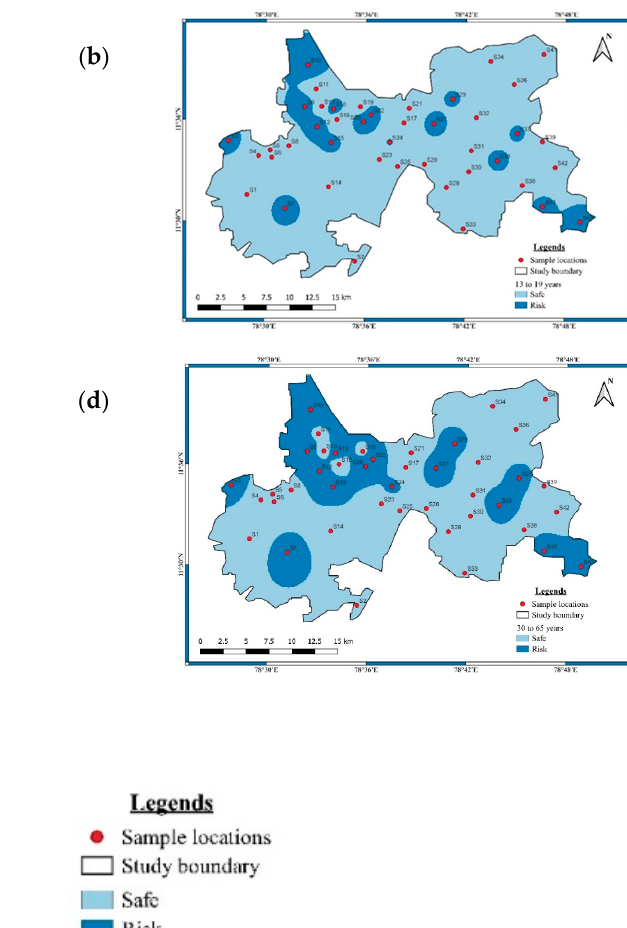
10 of 21 Figure 6. Nitrate contamination zones in the study area. Table 3. NPI classification of groundwater samples. NPI Value